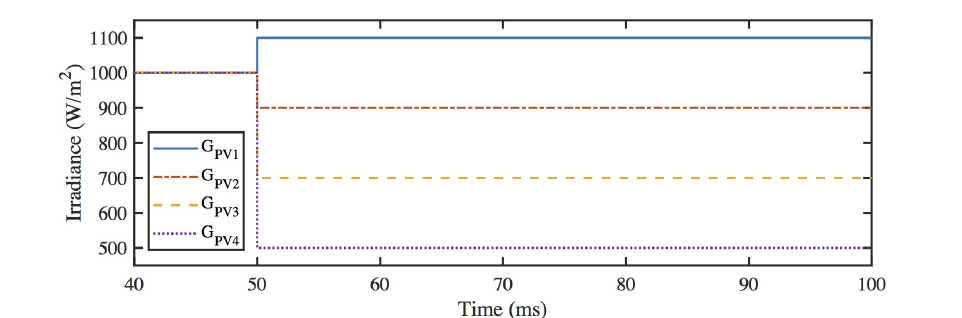
Figure 11. Irradiance values used in the